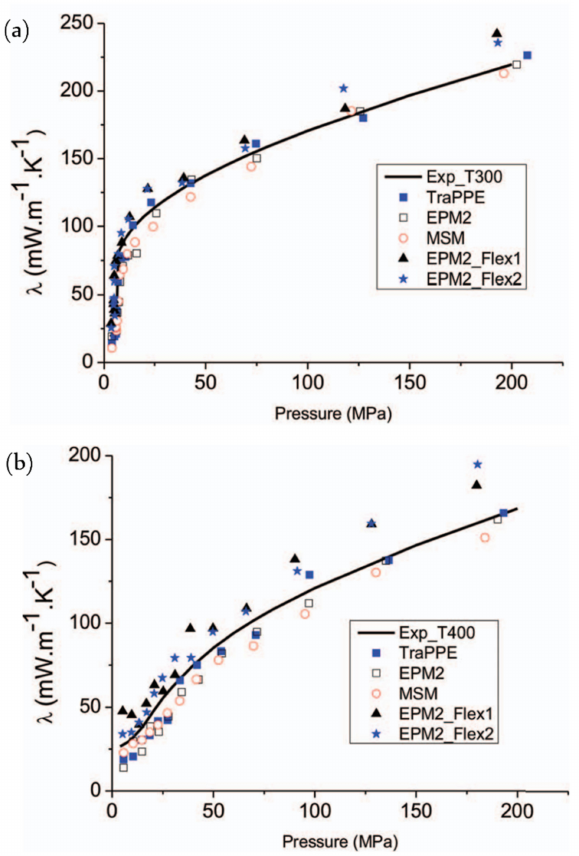
Figure 8. Thermal conductivity based on rigid and flexible MD predictions at ( a ) T = 300 K and ( b ) T = 400 K. The straight lines are extracted NIST data. (For in-depth interpretation of these data, the readers are referred to Trinh et al. paper